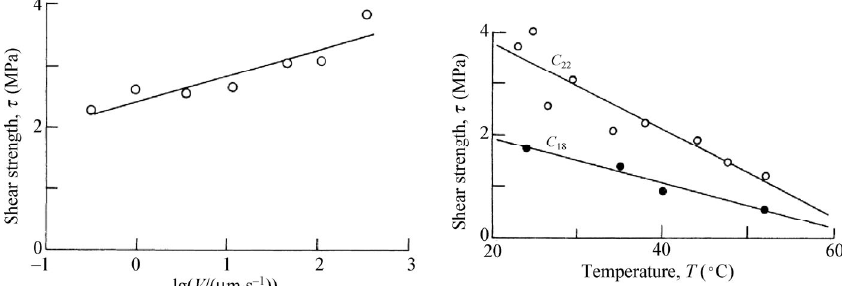
Fig. 8 (a) Shear strength of stearic acid monolayers at 21 °C. (b) Shear strength against temperature for stearic and behenic acid monolayers. Reproduced with permission from [84]. Copyright The Royal Society,